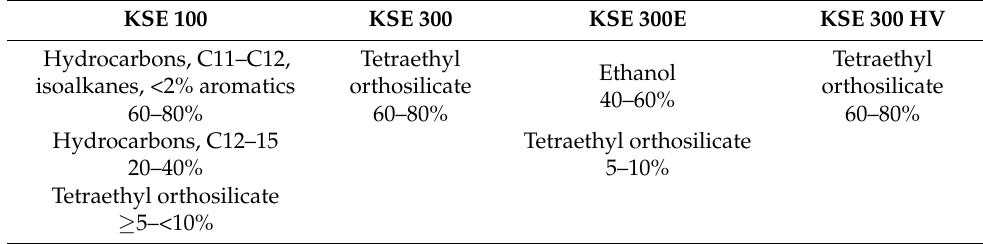
Table 1. Composition of the tested consolidants according to safety data sheets from producer (Remmers